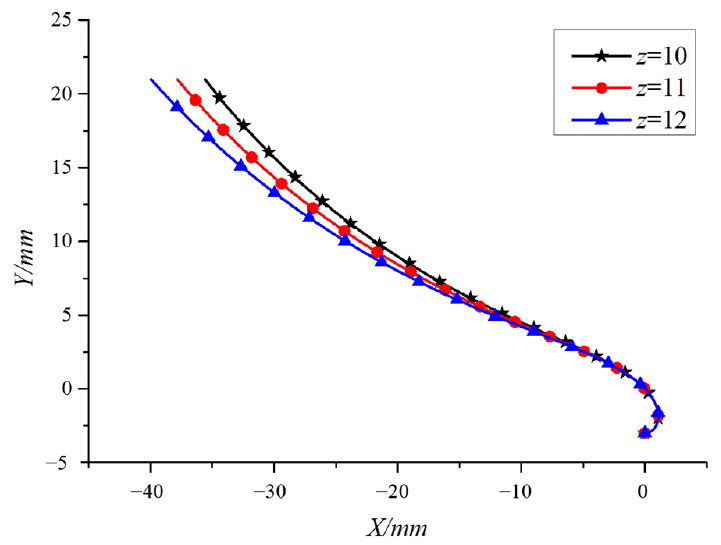
Figure 14. The influence law of z on the line of action. The influence law of the module m on the line of action is shown in Figure 15. It can be seen that the change of m has a certain influence on the start and end points of the line of action. The ordinate of the starting point of the line of action decreases with the increase of m , the abscissa of the end point of the line of action decreases with the increase of m , the ordinate of the end point of the line of action increases with the increase of m , and the length of the line of action increases with the increase of m .